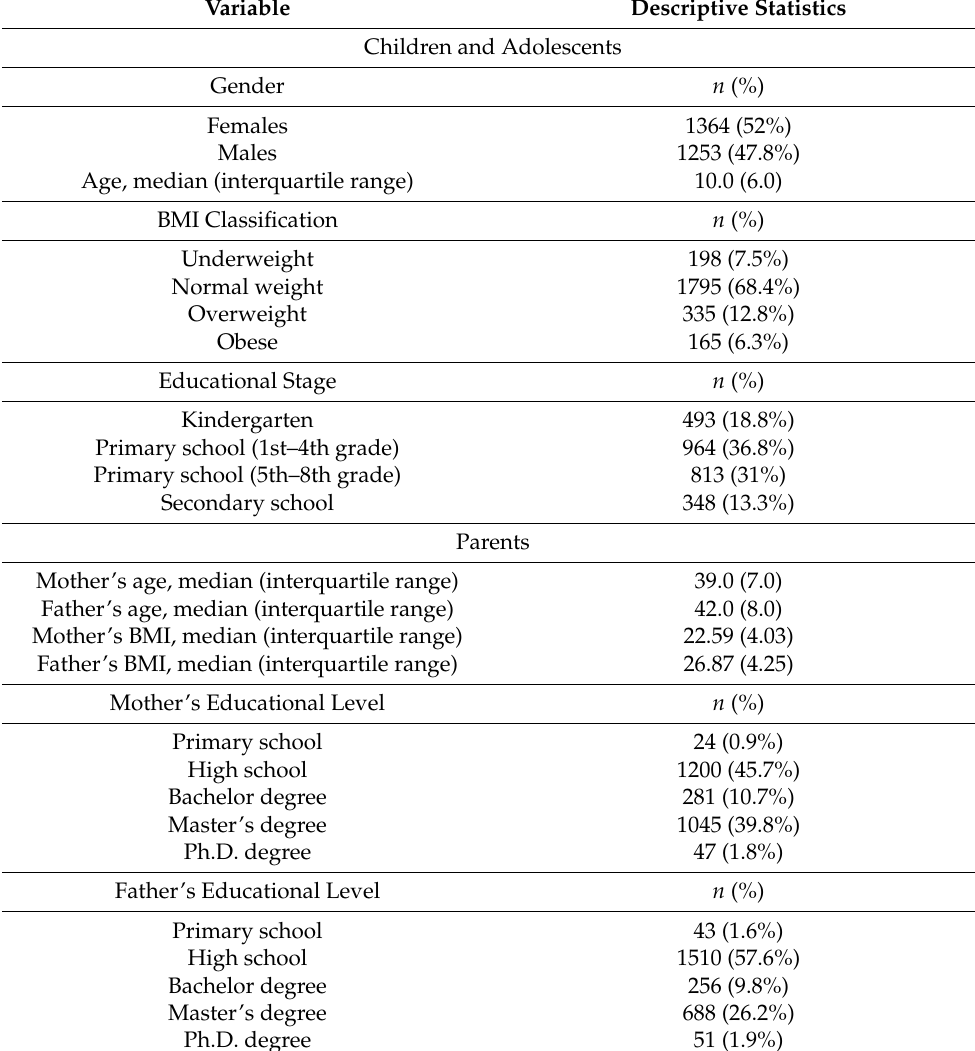
Table 1. Basic characteristics of the study participants.